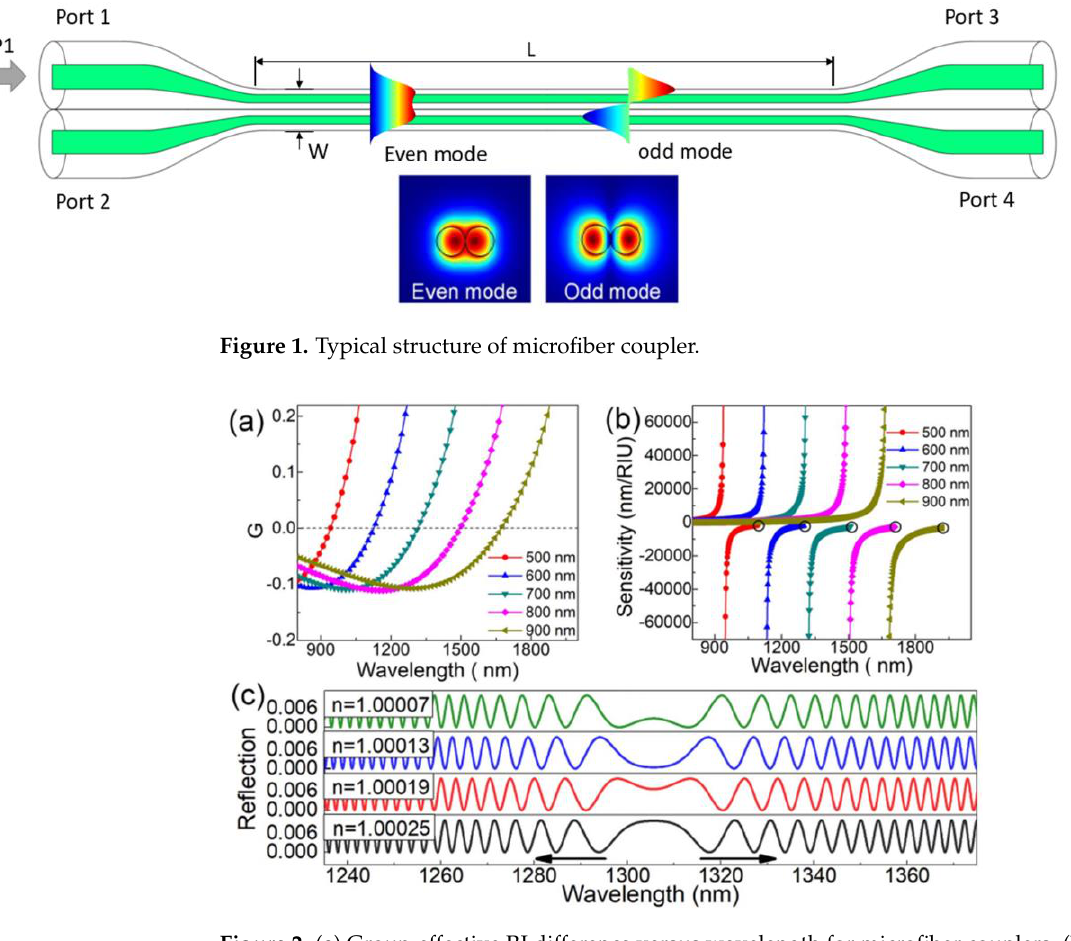
Figure 2. ( a ) Group-effective RI difference versus wavelength for microfiber couplers. ( b ) Calculated sensitivities as a function of wavelength. ( c ) Simulated reflective spectra with different surrounding RIs [13].